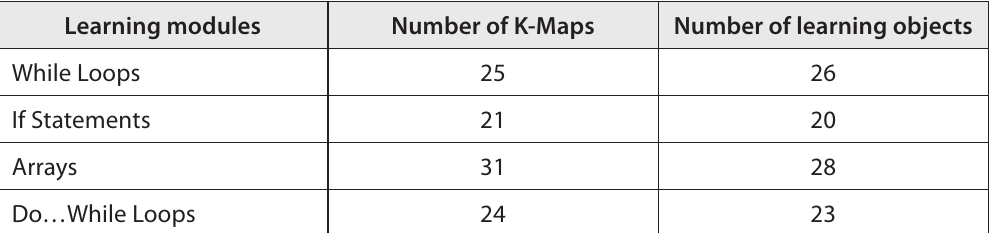
Table 2 Learning objects constructed using knowledge maps within the learning modules